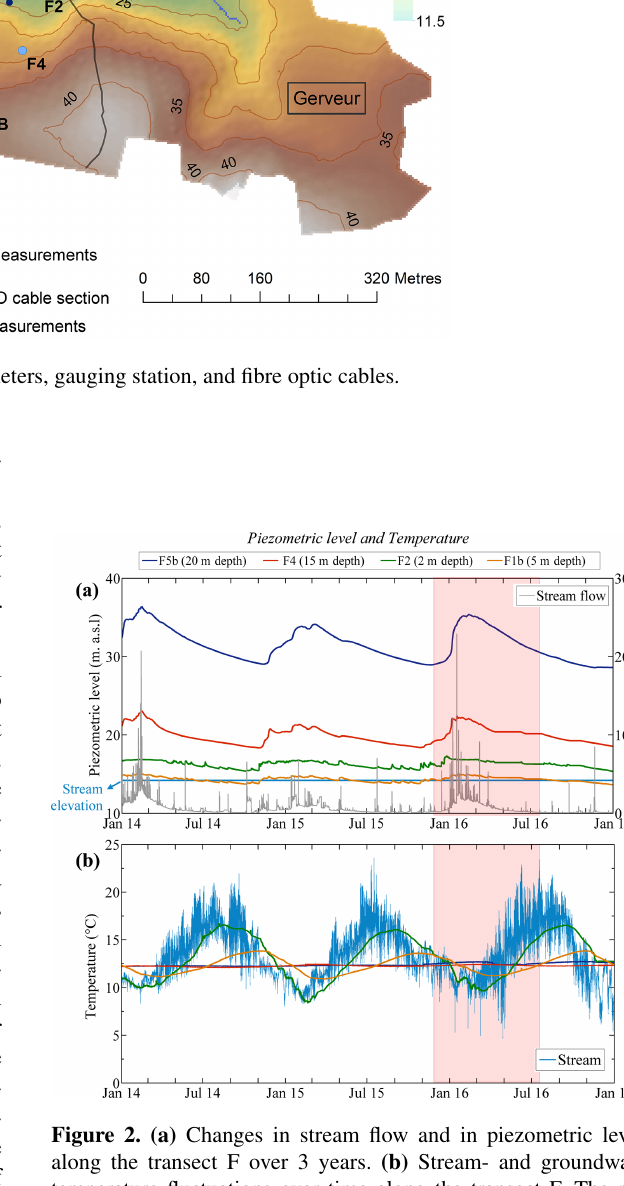
Figure 2. (a) Changes in stream flow and in piezometric levels along the transect F over 3 years. (b) Stream- and groundwater temperature fluctuations over time along the transect F. The red- coloured area corresponds to the period of passive DTS measure- ments conducted from December 2015 to 15 July